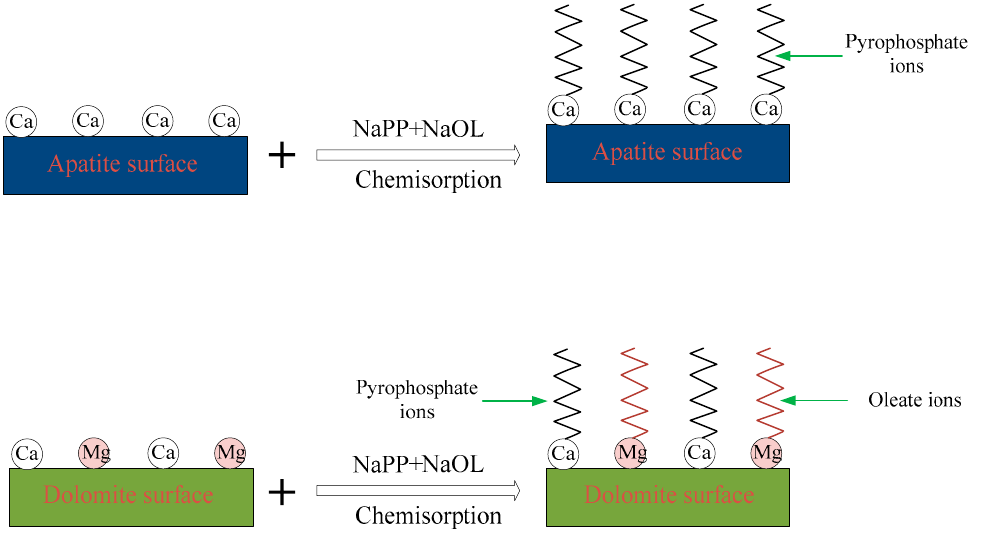
Figure 9. Schematic diagram of potential depression mechanism of NaPP.